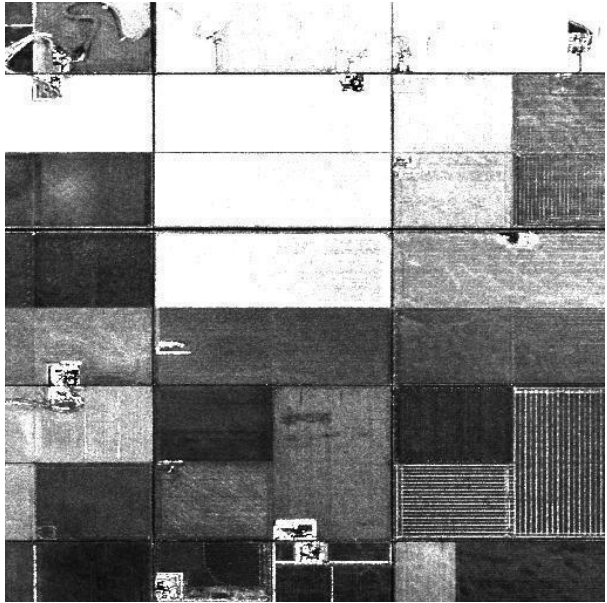
Figure 5. Span image of polarimetric data Segmentation of PolSAR images is shown in Figure 6, Figure 7 and Figure 8 for different sizes of